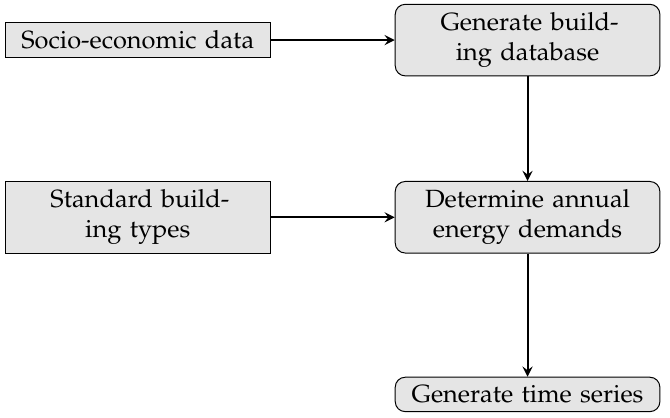
Figure 8. Conceptual approach to modeling bottom-up demand